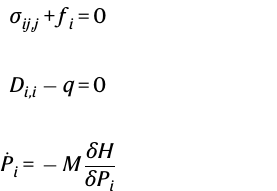
Fig. 19, the dislocation induced driving force was computed without the external electric fi eld, where the vertical dislocation spacing of 200nm (based on TEM images) was used. Two-dimensional simula- tions under the plane strain assumption was considered. Then, the driving force was used to calculate the energy landscape in Fig. 4g using Eqs. (9) and (10). The phase- fi eld model was numerically